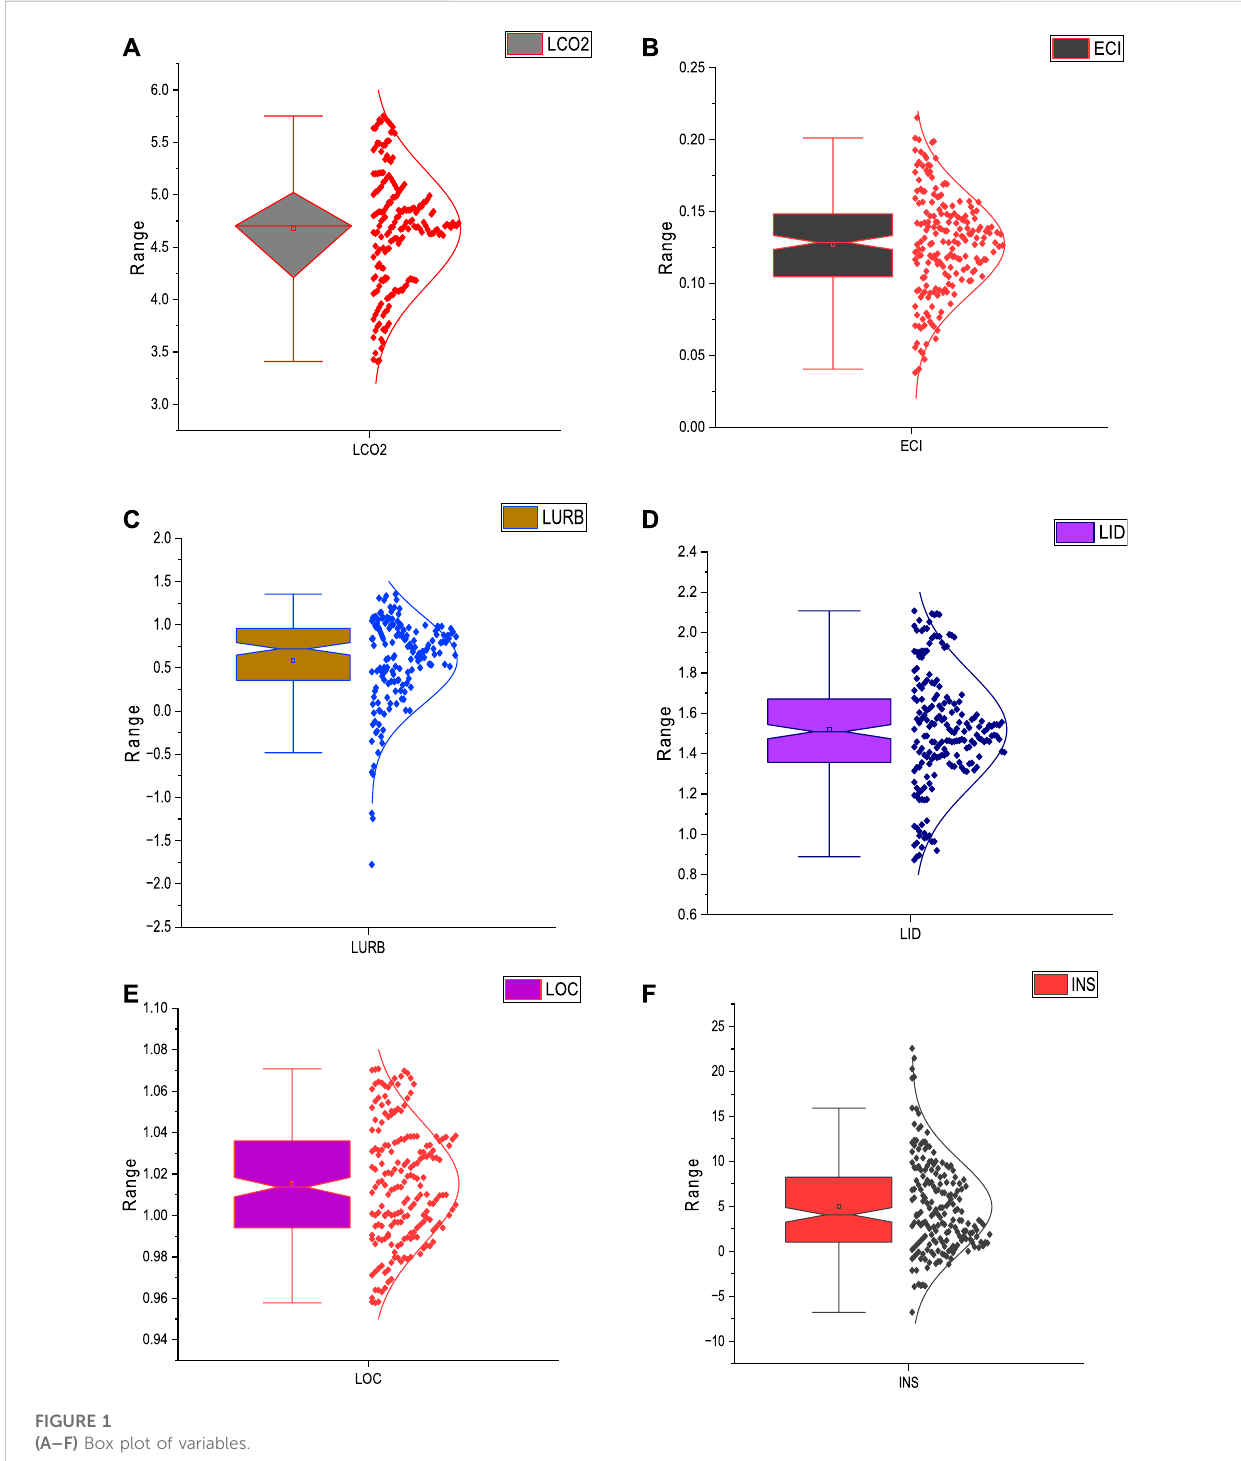
FIGURE 1 (A – F) Box plot of